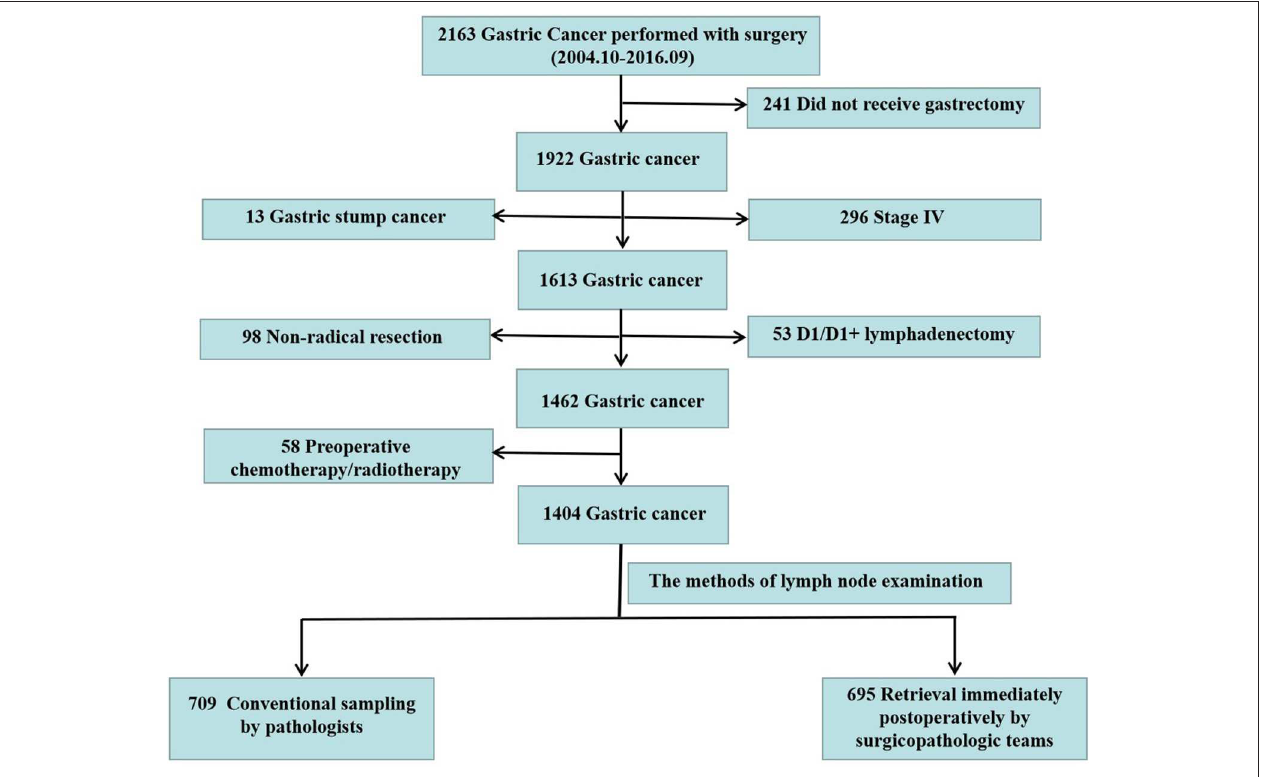
FIGURE 1 | Flow chart of the study